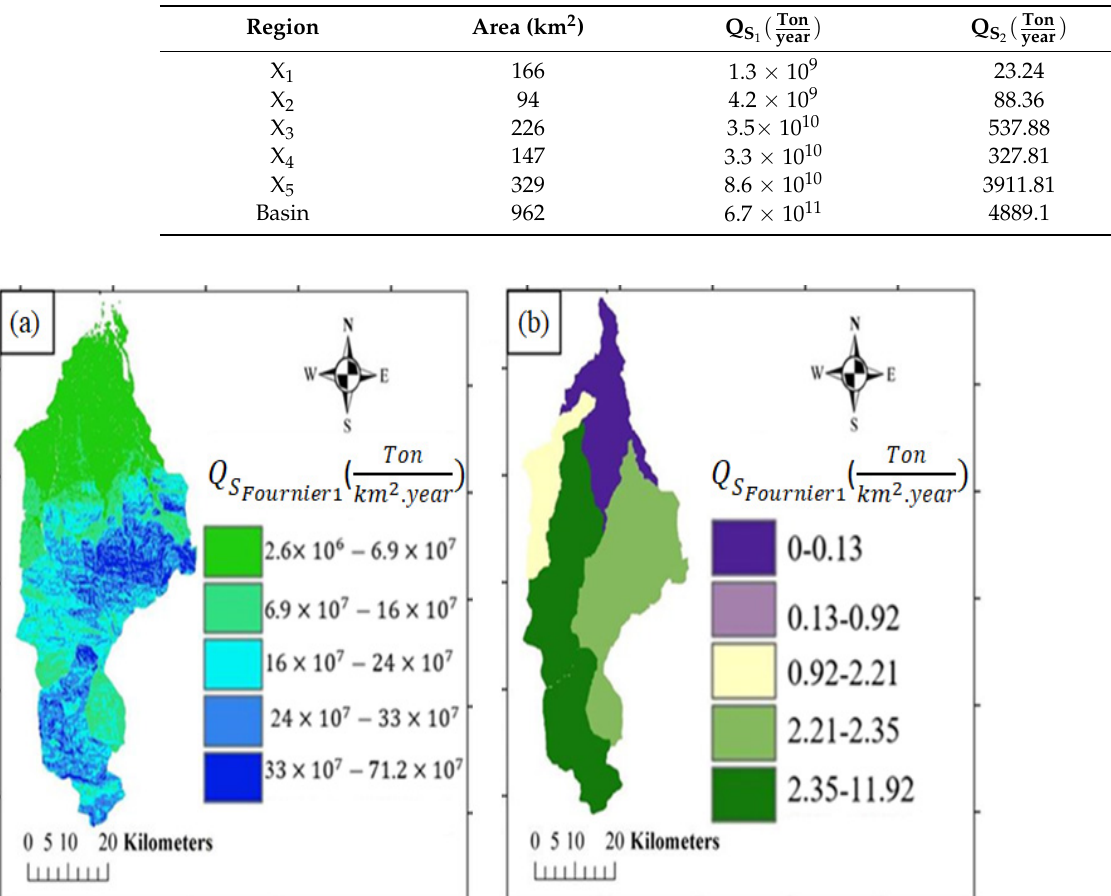
Table 11. Annual sediment yield of the Babolroud watershed based on ( a ) the first Fournier method and ( b ) the second Fournier method.